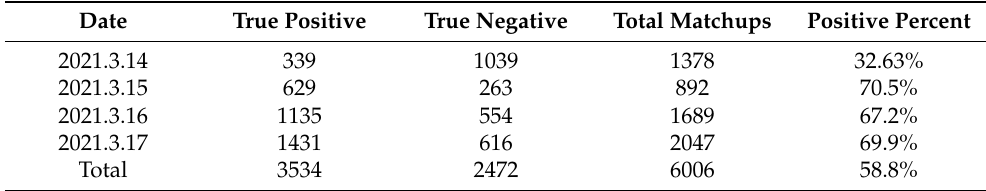
Figure 11. SESI (the yellow pixel) overlapped with false-color imagery (the grey area) on 14–17 March 2021. ( a ) 14 March 2021, ( b ) 15 March 2021, ( c ) 16 March 2021, and ( d ) 17 March 2021. Table 4. The pixel statistics of sand and dust identified by SESI and false-color imagery (“True Positive” means that both methods identified sand and dust pixels, “True Negative” means that the SESI method identifies but the false-color imagery does not).